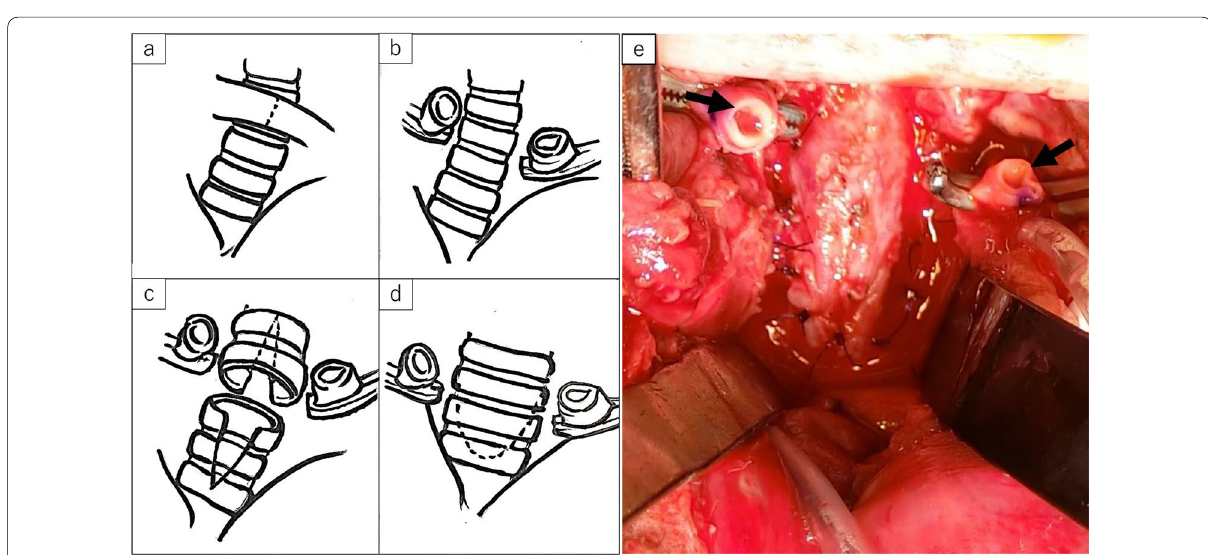
Fig. 4 Brachiocephalic artery (arrows) was transected to secure the upper field of slide tracheoplasty, and slide tracheoplasty was